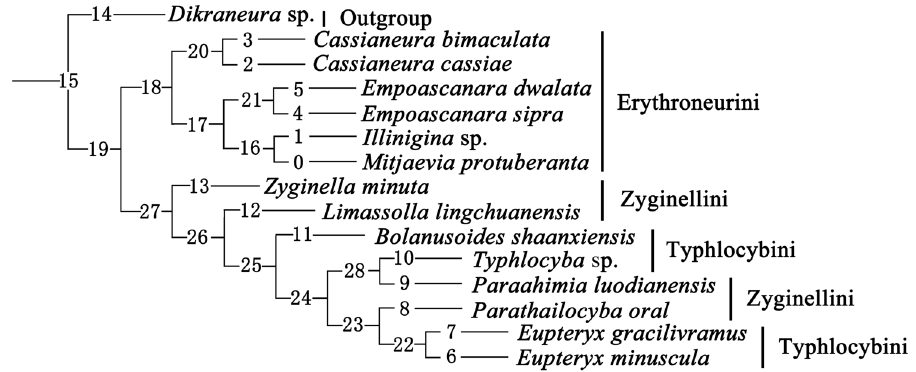
Figure 9. Phylogenetic tree established by traditional search methods based on 63 morphological traits. (Outgroup: Dikraneura